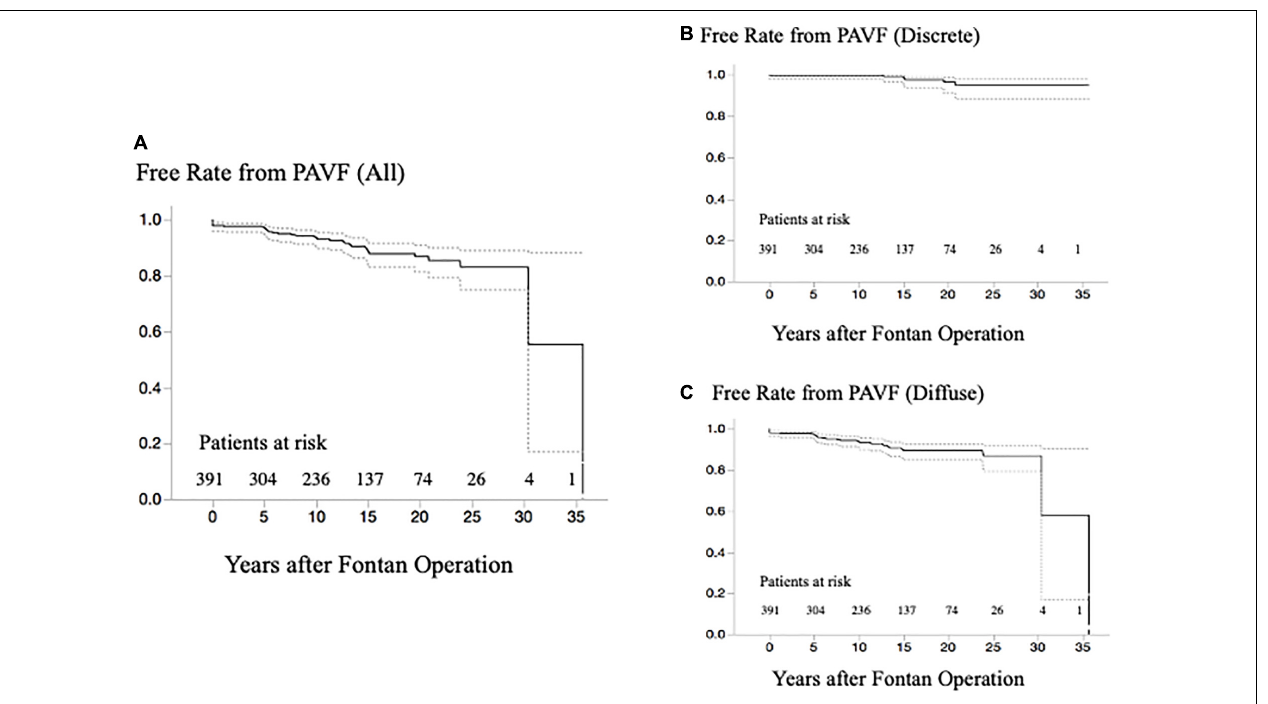
those with left isomerism ( p < 0.0001). The same statistical trend was observed in patients with discrete-PAVF. Table 2 . Compared to patients without PAVF, those with diffuse